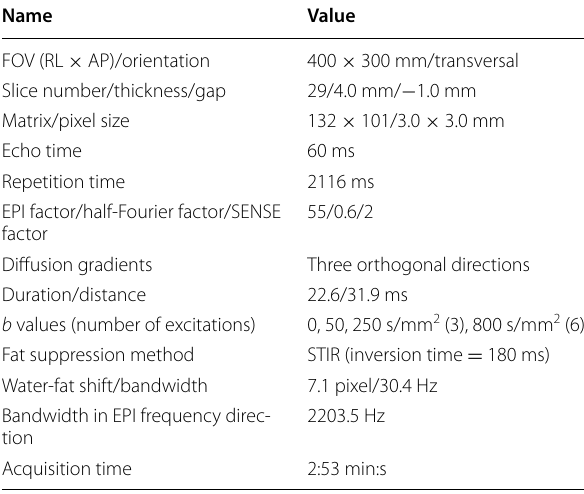
Table 2 Technical parameters of the diffusion-weighted imaging